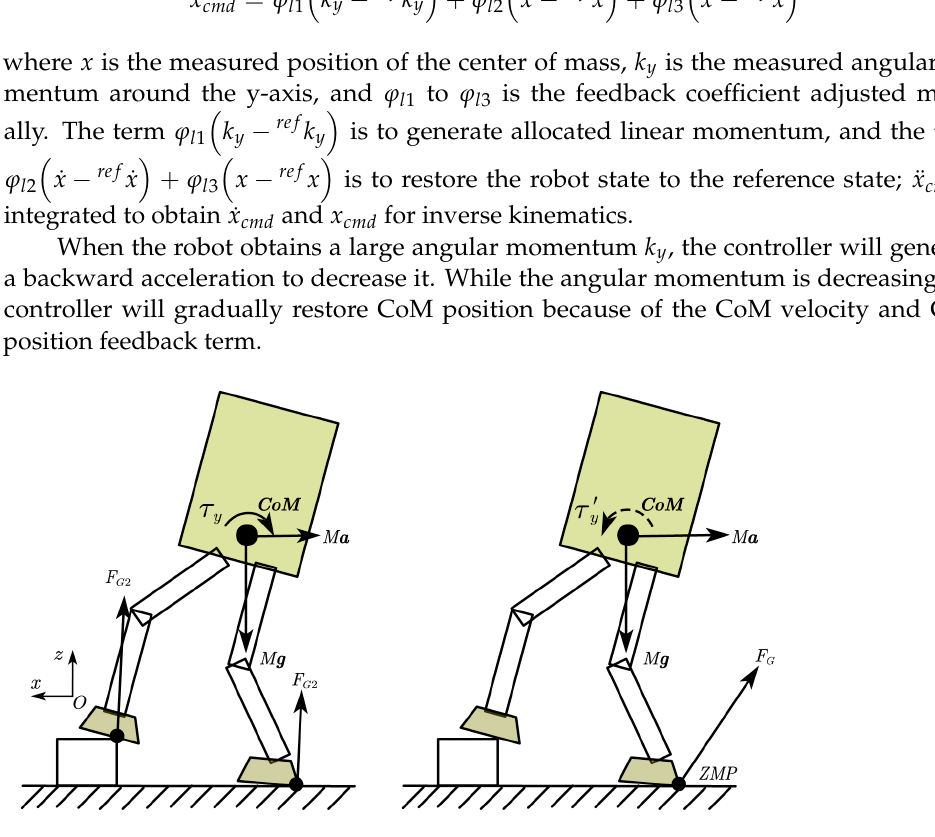
Figure 2. Angular momentum compensation strategy. The left side is the original situation, and the robot has a large rotation trend. On the right is the case of generating backward acceleration, which reduces the rotation